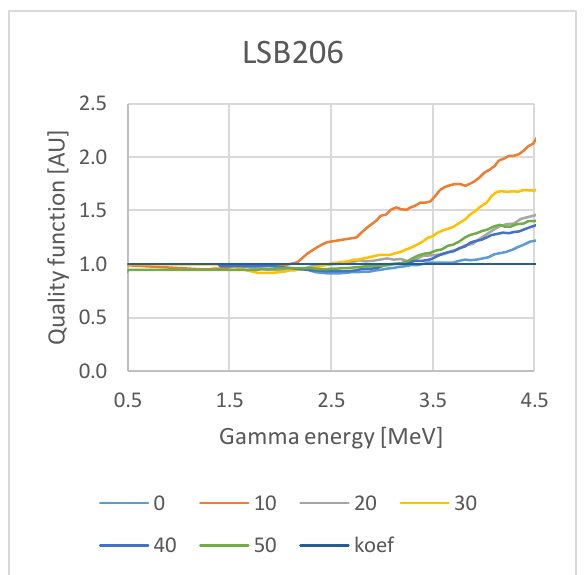
Fig. 3. FOM temperature dependencies of